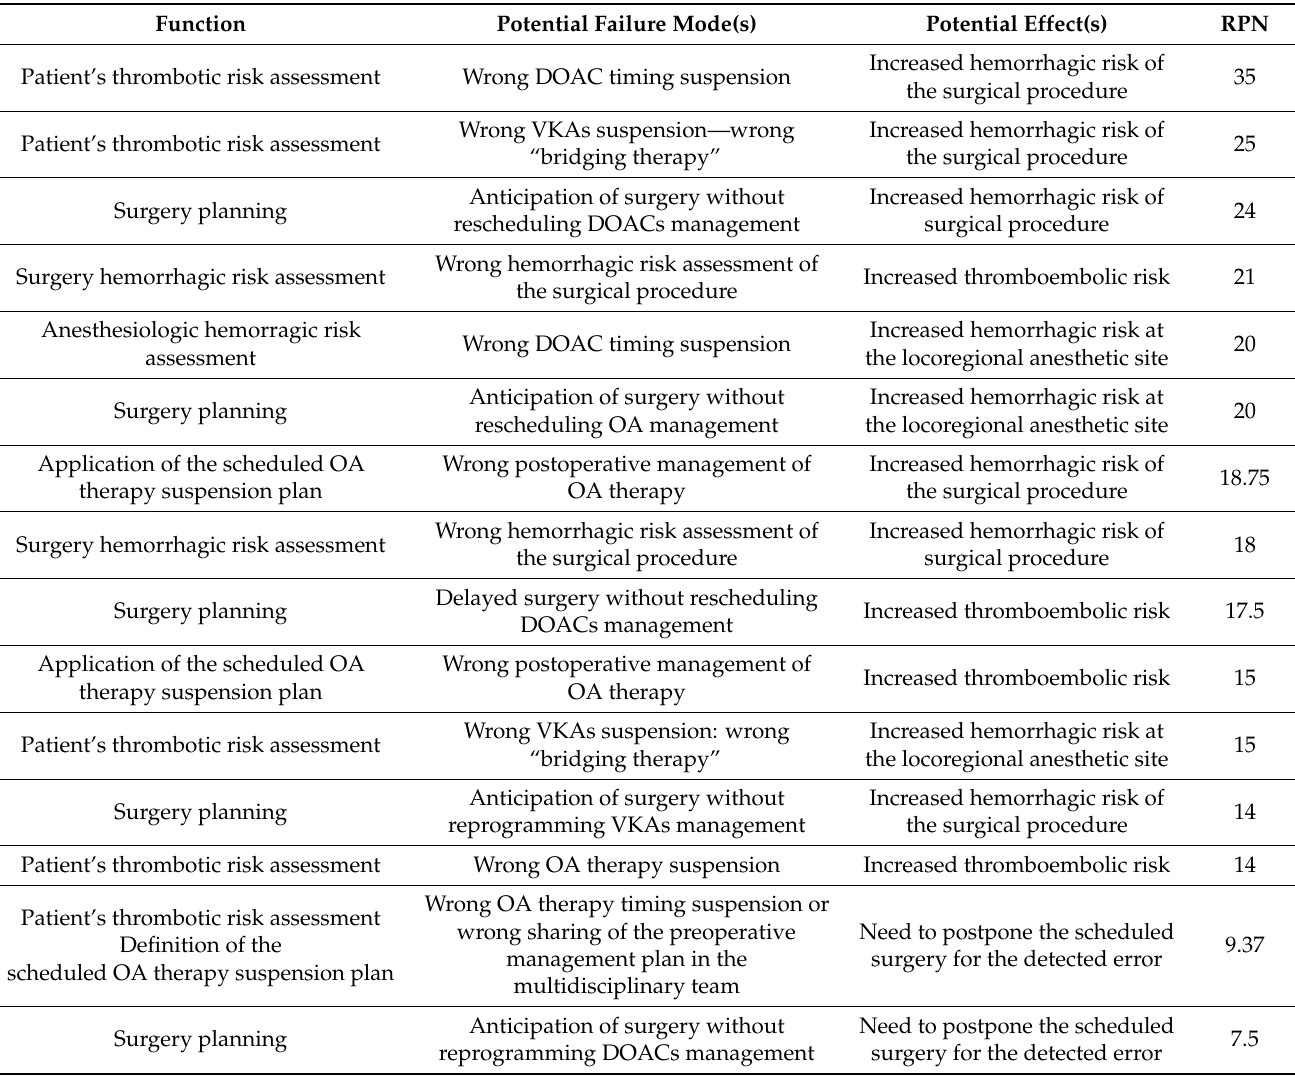
Table 3. Proposed master list as resulted from the failure modes of the FMEA application to perioper- ative management of OA